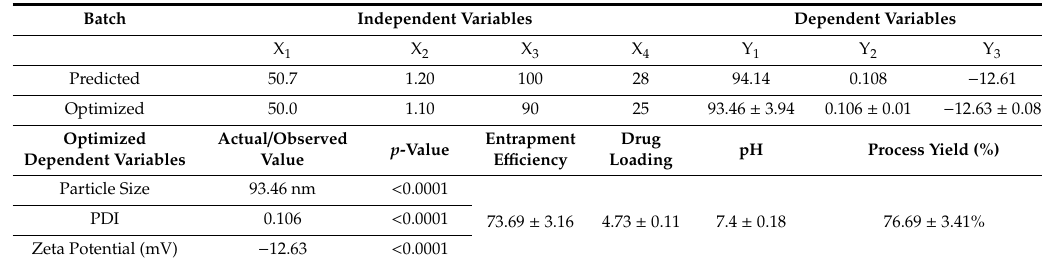
Table 4. Optimal predicted and optimized batch of CH–PLGA–NPs with independent variables and dependent variables with other characterizations of optimized